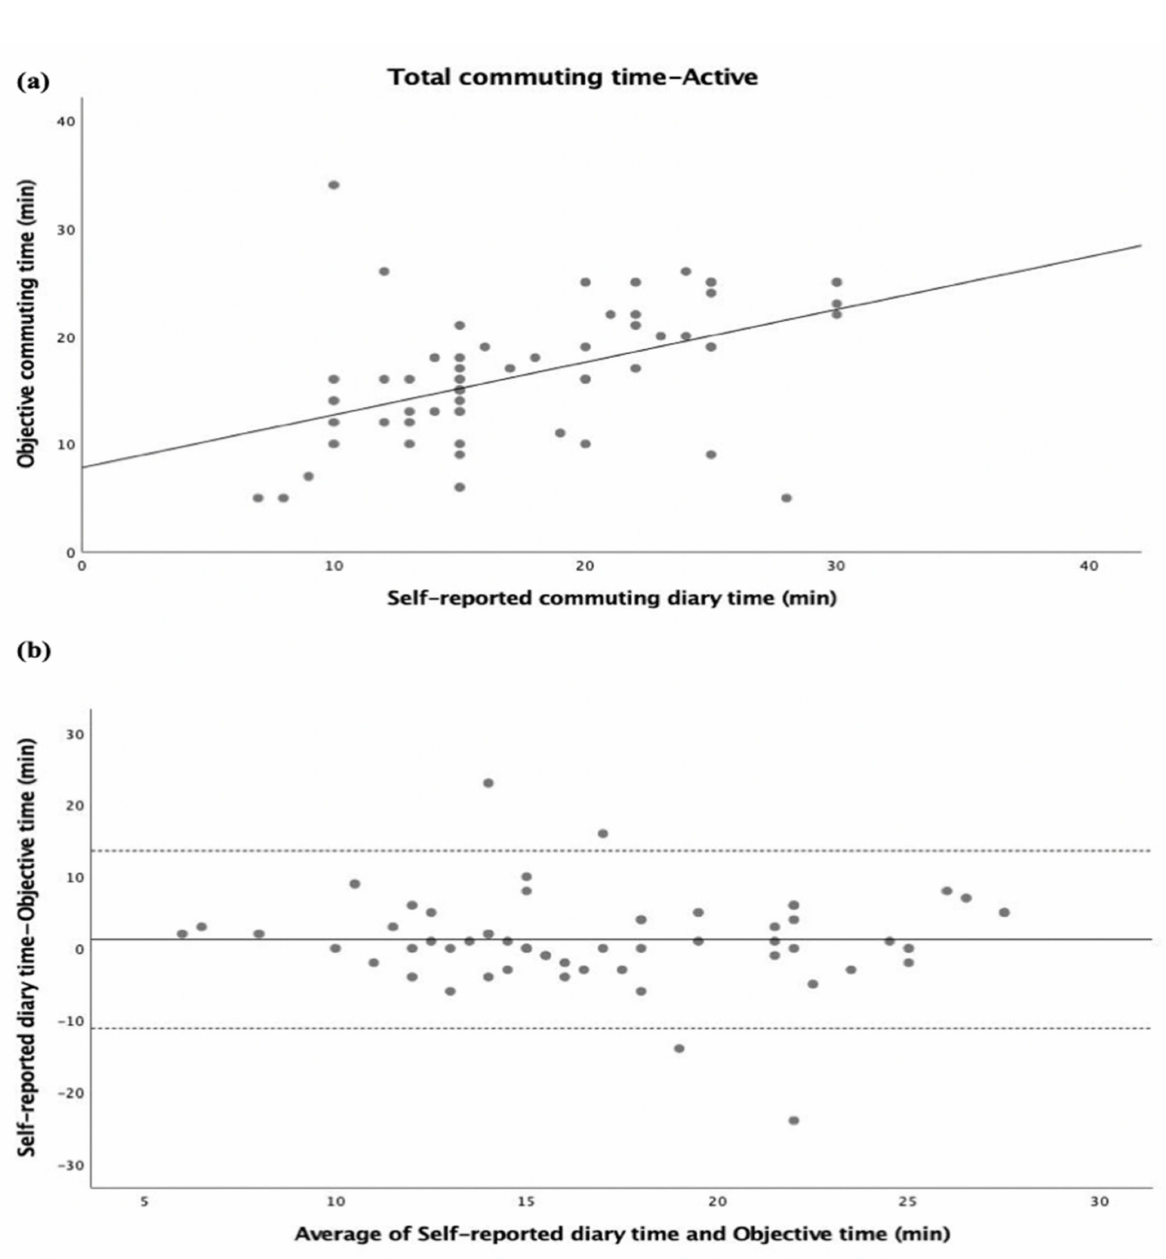
Figure 3. Commuting time expressed as minutes (total commuting time—active). ( a ) Regression of the objective commuting time (y) vs. (x) the self-reported commuting diary time. The regression equation is y = 7.79 + 0.49x. ( b ) Bland–Altman plot of the total commuting time between self-reported diary time and objective time (y) vs. average of self-reported diary time and objective time (x). The central dotted line represents the mean of differences between the objective time measure and the self-report time measure; the upper and lower dotted lines represent the upper and lower 95% limits of agreement (mean differences + 1.96 standard deviations of the differences), respectively. Adolescents reported 6.63 min more in the total commuting time than the objective time (95% limits of agreement were 23.31 min and − 36.57